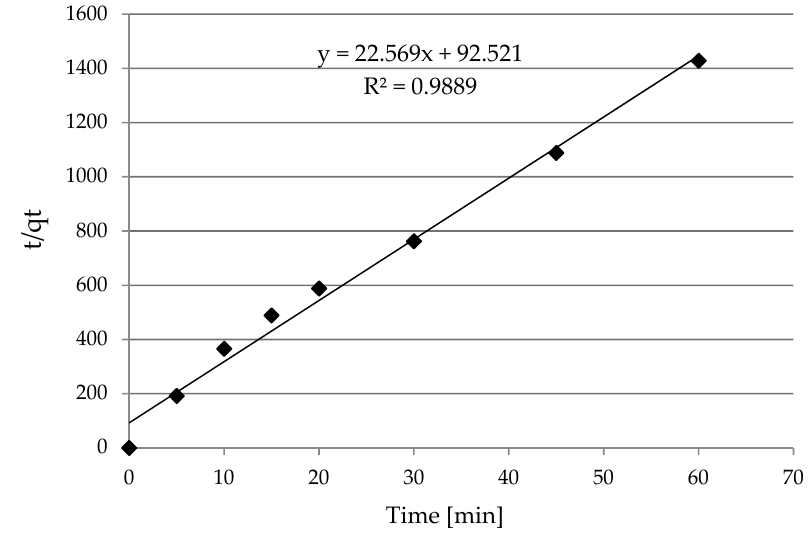
Figure 12. The pseudo second-order kinetic plot for the adsorption of Ni(II). Table 3. Adsorption parameters of pseudo-first-order and the pseudo-second-order rate equations. Pseudo-First-Order Kinetic Model Pseudo-Second-Order Kinetic Adsorbent Metal Ion Dosage [g/L]